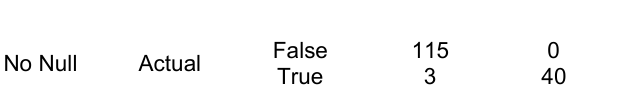
Table 9. Confusion Matrix for Quadratic